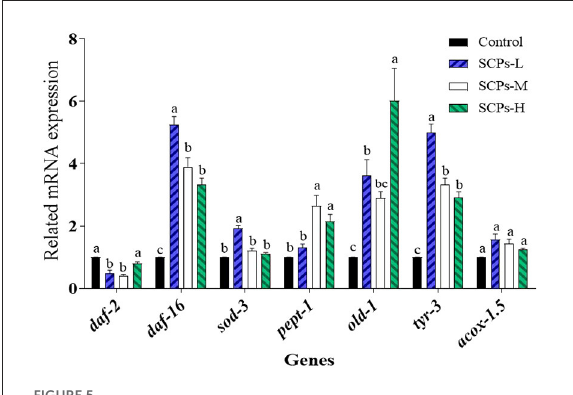
FIGURE5 Effect of SCPs on the relative expression levels of anti-aging related genes in C. elegans . Data were expressed as the mean ± SD. Different letters correspond to statistically significant differences ( p < 0.05) between groups in the same